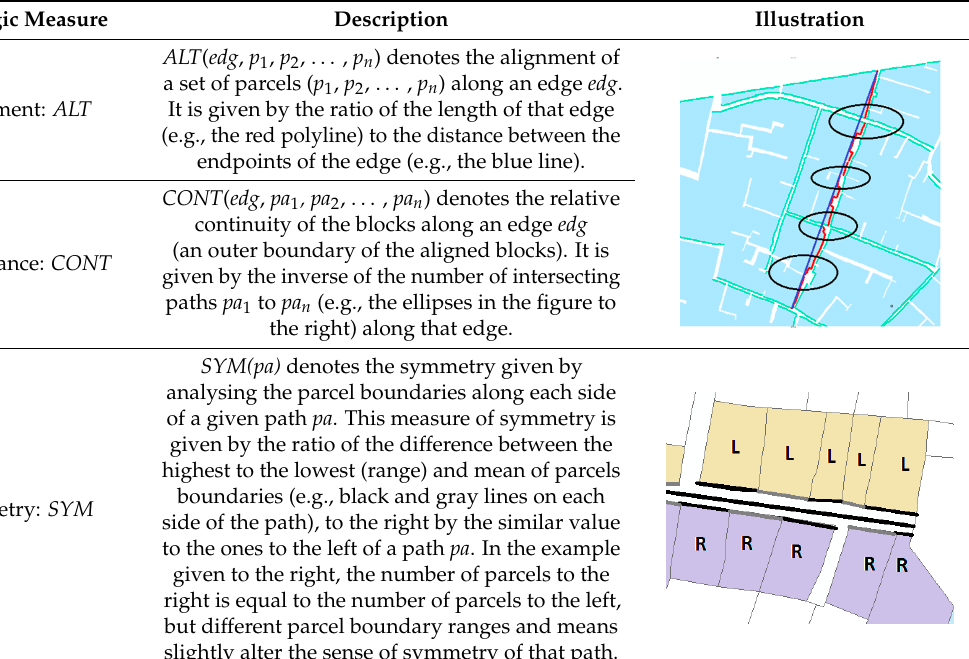
Table 5. Configuration-based measures used to measure urban layout components.